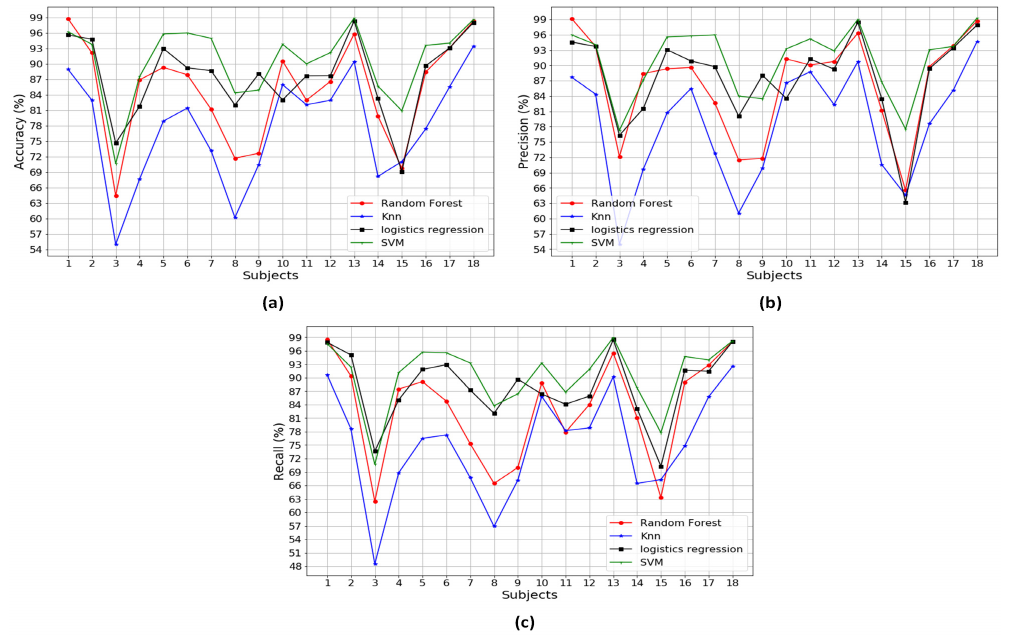
Figure A1. The classification performances of methods using a combination of three different types of sensors: pressure sensors, accelerometer and gyroscope: ( a ) accuracy performance; ( b ) precision performance; and ( c ) recall performance.